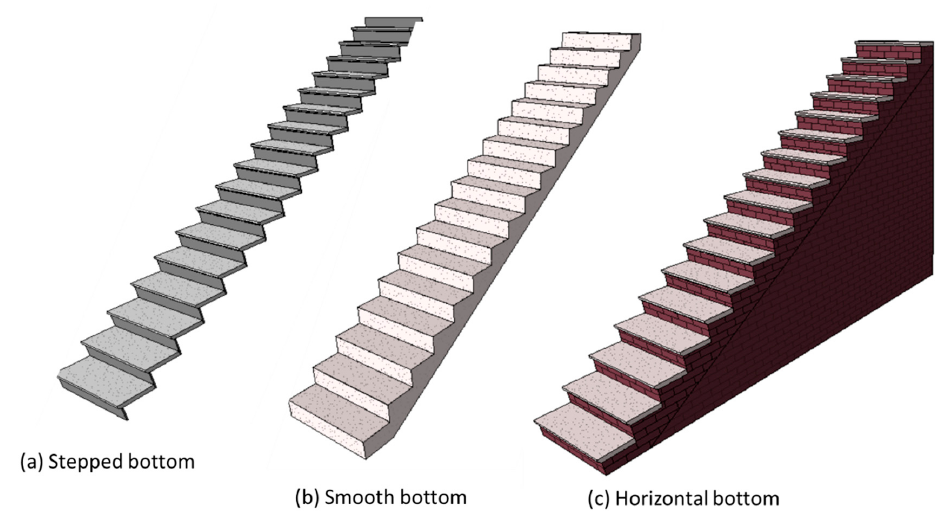
Figure 5. Monolithic stairs.